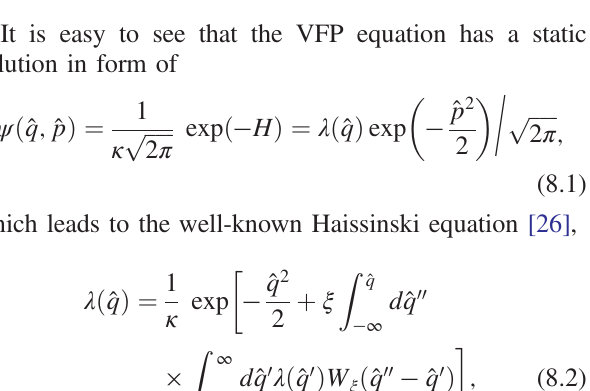
FIG. 6 (color online). Simulation results of the threshold as a function of the shielding parameter for rectangular chambers with various aspect ratios. The solid line represents ξ th ¼ 0 . 5 þ 0 . 34 χ for the parallel plate